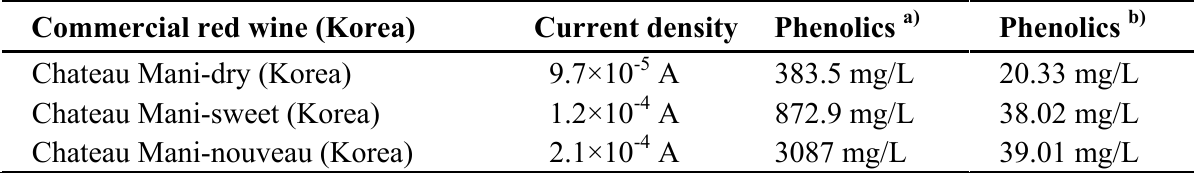
Table 2. Total phenolic concentration determined by the MWNT ionic liquid electrode based on tyrosinase for commercial red